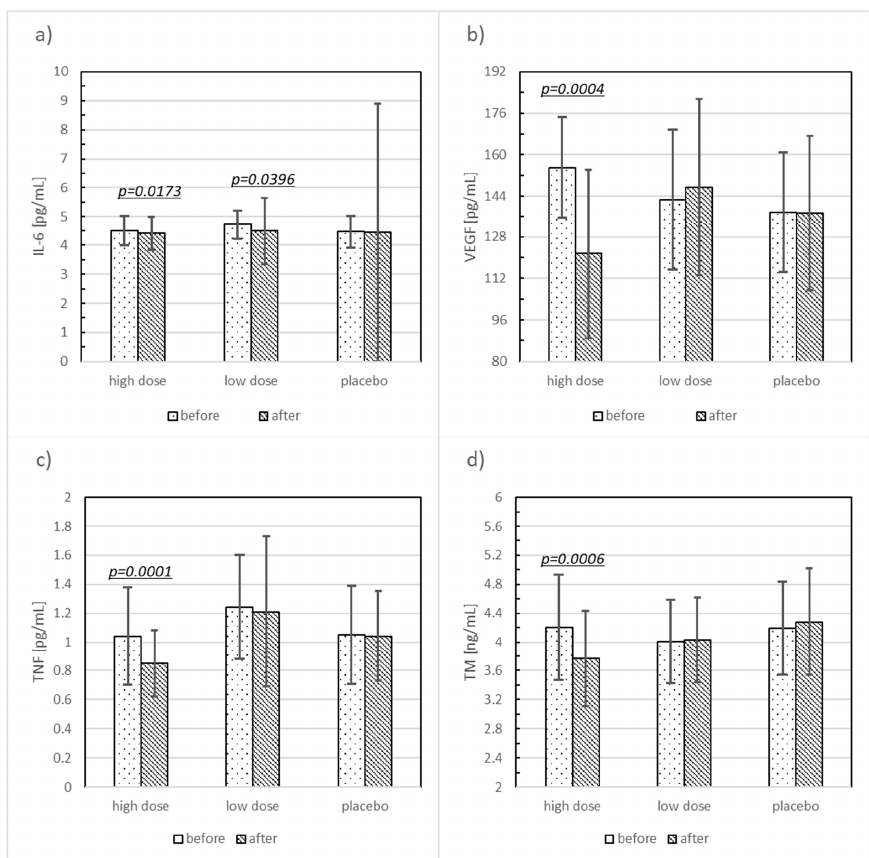
Figure 3. The comparison of the biochemical parameters in the high dose (HD), low dose (LD), and placebo groups at the beginning of the study and after three months of probiotic supplementation. Significant differences are highlighted showing the p -value. Data are arithmetic mean ± SD; ( a ) Il-6: interleukin-6; ( b ) VEGF: vascular endothelial growth factor; ( c ) TNF: tumor necrosis factor alpha; ( d ) TM: thrombomodulin. Table 2. The comparison of the tested parameters in the high dose (HD), low dose (LD), and placebo groups at the beginning of the study and after three months of